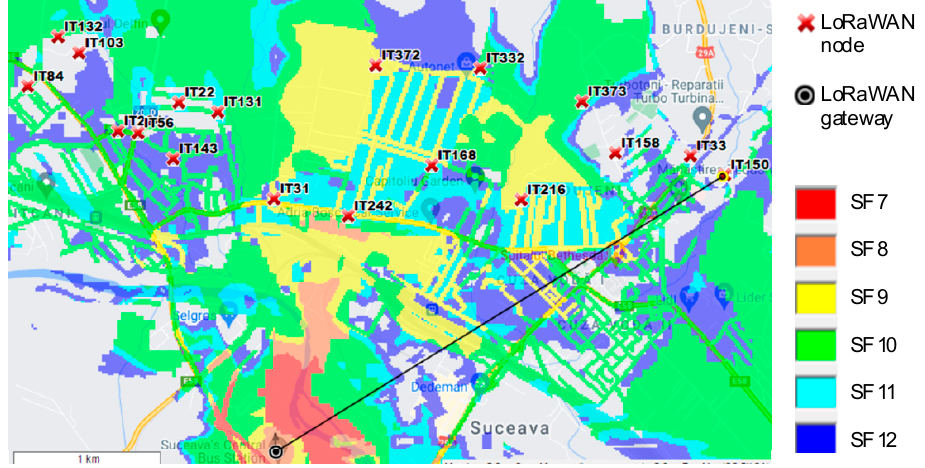
Figure 11. LoRaWAN Coverage Scenario 2.